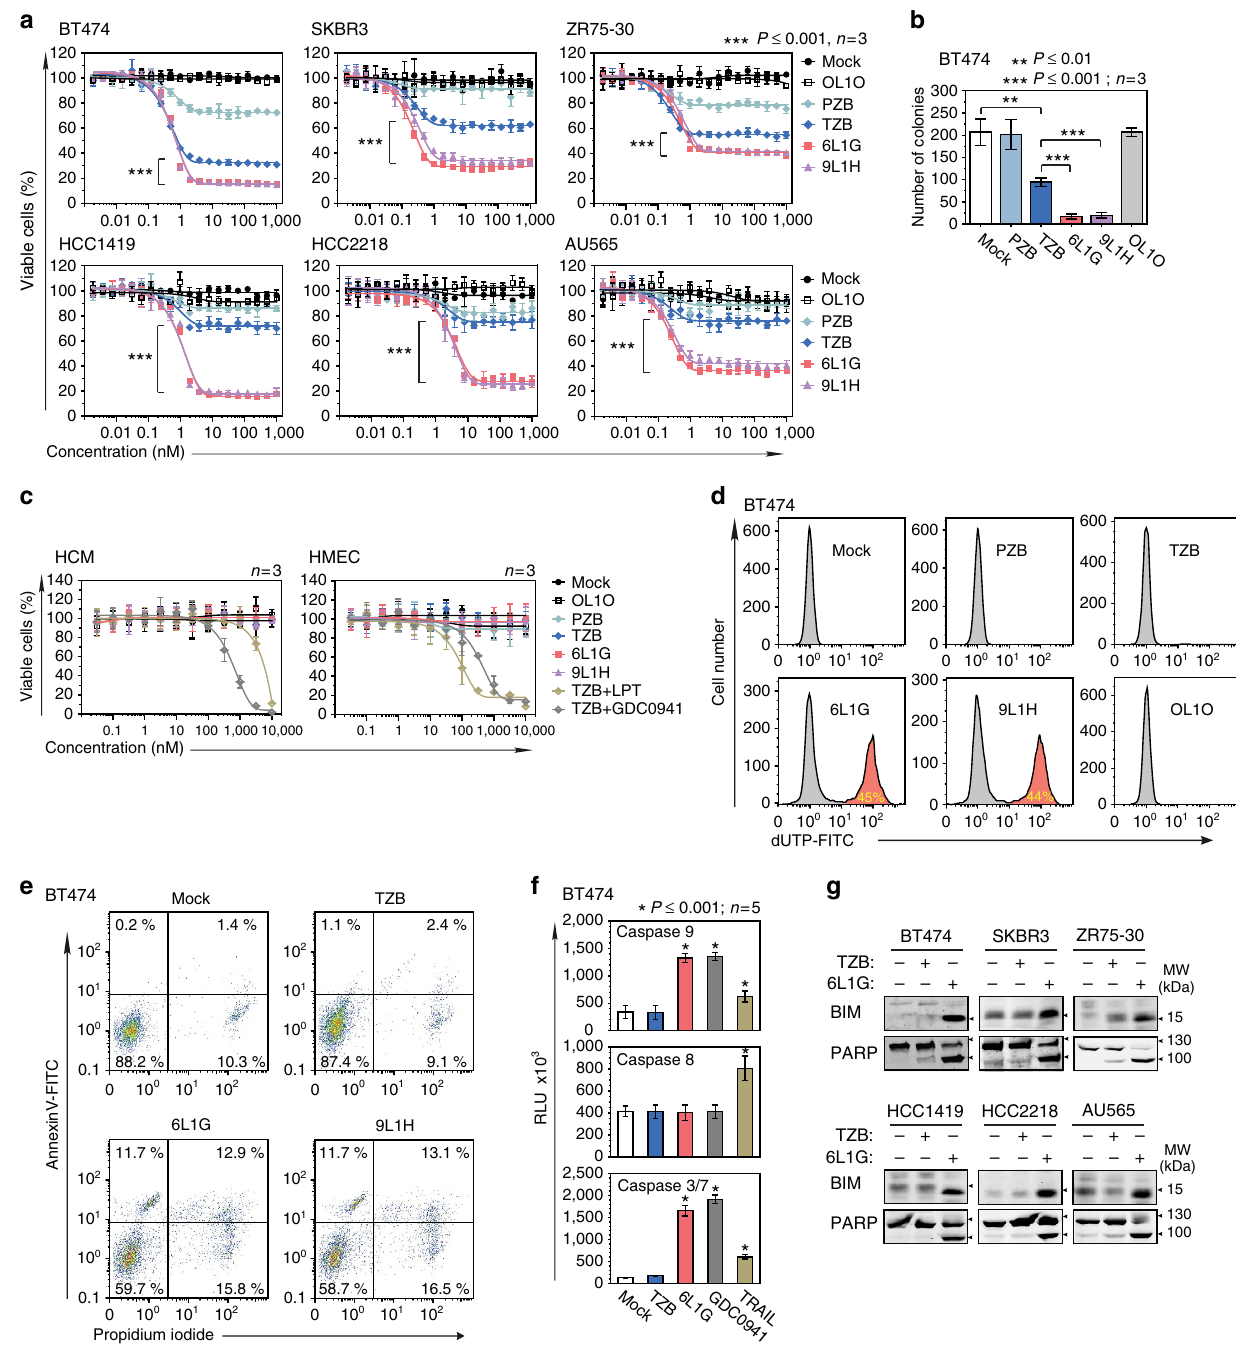
Figure 2 | Induction of apoptosis upon trapping of ErbB2 by biparatopic agents. ( a ) Inhibition of proliferation of ErbB2-overexpressing breast cancer cell lines (XTTassay). Cells were treated for 96h with 6L1G or 9L1H, non-binding DARPin control (OL1O), trastuzumab (TZB), pertuzumab (PZB) or PBS alone (mock); (* P value plateau 6L1G versus plateau TZB, two-sided, unpaired Student’s t -test). ( b ) Colony growth of BT474 cells, treated for 96h with 100nM of indicated agents. The capacity of single cells to initiate colony outgrowth was determined by a clonogenic assay after 5-week re-culturing (two-sided, unpaired Student’s t -test). ( c ) Proliferation of human cardiomyocytes (HCM) or embryonic human cardiomyocytes (HMEC) after 96h of treatment (XTT assay). In addition to the same samples as applied in a , the cells were also treated with 100nM TZB combined with lapatinib (LPT) and GDC-0941 at the concentrations indicated. ( d ) Induction of apoptosis as determined by TUNEL assay in histogram representation (apoptotic cells in red). Cells were treated with 100nM of indicated agents for 72h and analysed by FACS (Supplementary Fig. 2K). ( e ) Annexin V/propidium iodide (PI) assay of BT474 cells after 24h treatment with 100nM of indicated agents. Early apoptotic cells were monitored by Annexin V-FITC detection (upper left and right quadrants). Staining for membrane permeability (PI at 1 m gml (cid:2) 1 ) indicates the late stages of cell death (upper and lower right quadrants). ( f ) Caspase activity in cell extracts from BT474 cells treated with 100nM 6L1G or TZB for 72h or 1 m M GDC-0941 or 10ngml (cid:2) 1 TRAIL for 12h, determined by assays using specific chemiluminescent substrates for Caspase-3/7, 8 and 9 (* P value versus TZB, two-sided, unpaired Welch’s t -test). ( g ) Analysis of apoptotic markers PARP cleavage (p89) and BIM expression after 72h treatment with 100nM of indicated